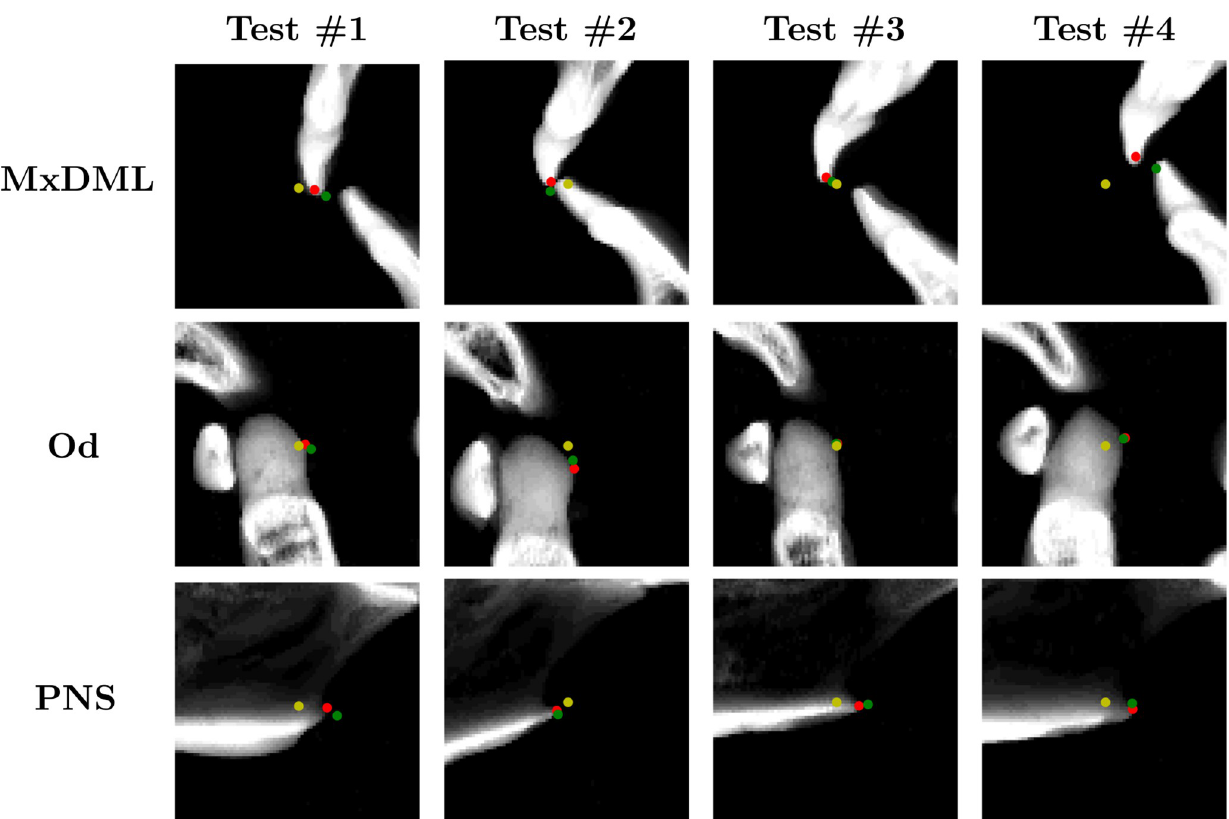
Fig 9. Results of coarse-to-fine landmark detection on 2D patch. Yellow dot is the output of the coarsely detected VAE. Green dot is the output of detection using patch-based CNN. Red dot is the ground truth.